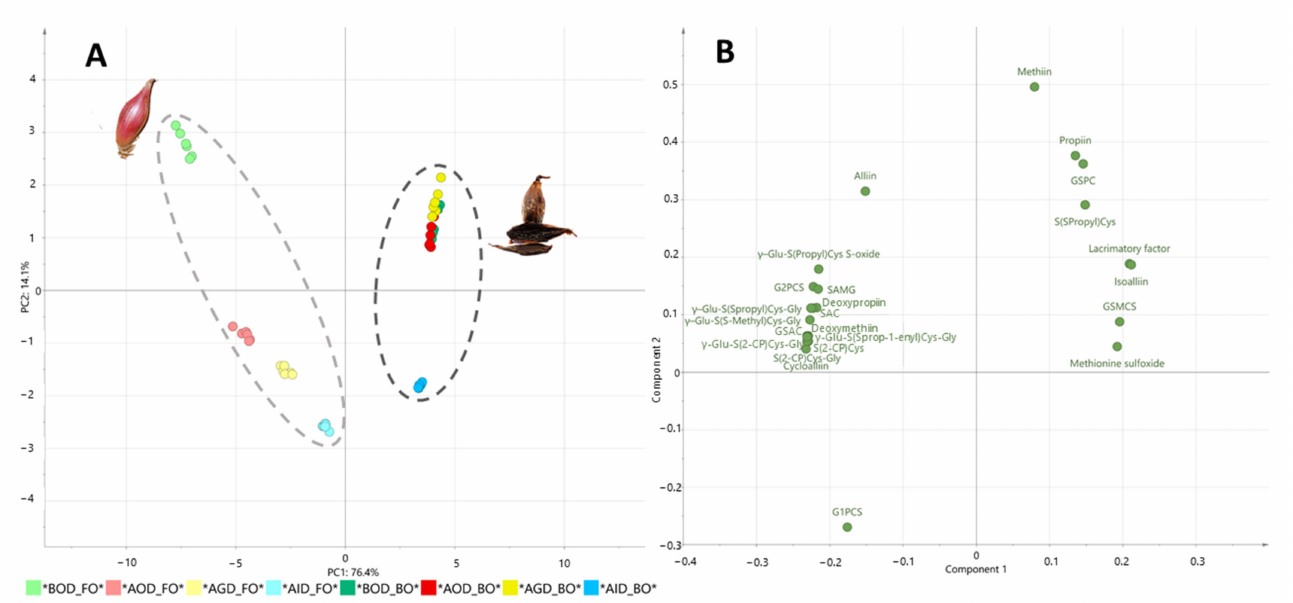
Figure 3. Scores ( A ) and loadings ( B ) of the PCA comparing data from organosulfur compounds of fresh and black onion during simulated gastrointestinal digestion.